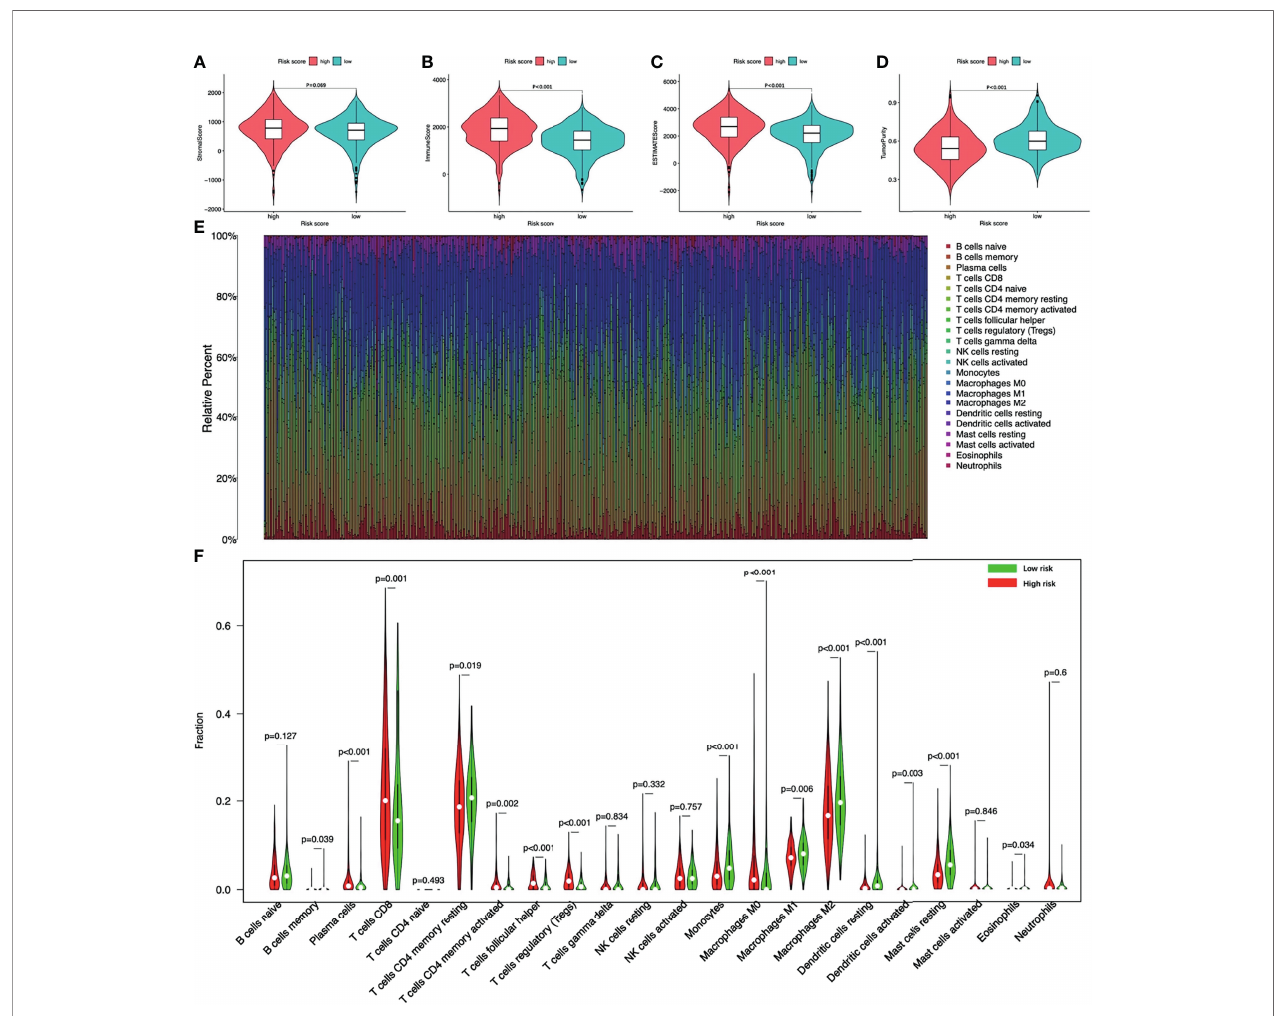
FIGURE 9 | The tumor microenvironment and immune in fi ltration of ccRCC. The tumor microenvironment between high-risk and low-risk groups (A) Stromal score; (B) Immune score; (C) ESTIMATE score; (D) Tumor purity. (E) The landscape of immune cell in fi ltration of all ccRCC patients. (F) The in fi ltrating levels of 22 immune cell types between high-risk and low-risk groups. ccRCC, clear cell renal cell